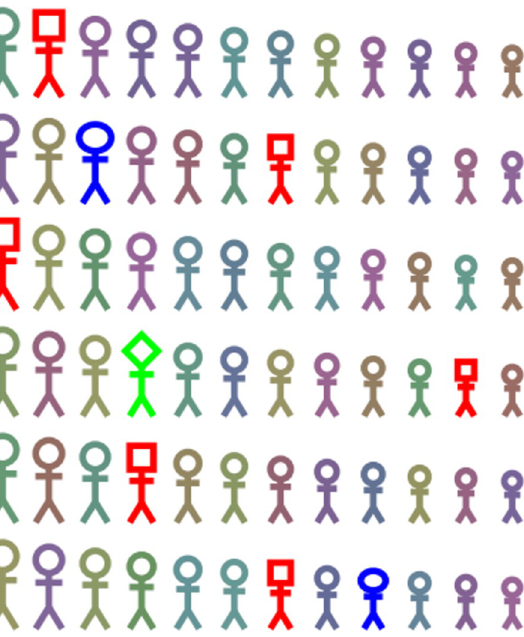
Fig 1. Common variation in quantitative traits such as height, represented by size, and blood pressure, represented by different colors, present a diverse background of traits and disease susceptibility, upon which rare phenotypes are observed, represented by different shapes and colors. The Human Genetic Variation and Disease section will support manuscripts on any (or all) of these aspects of human genetics.